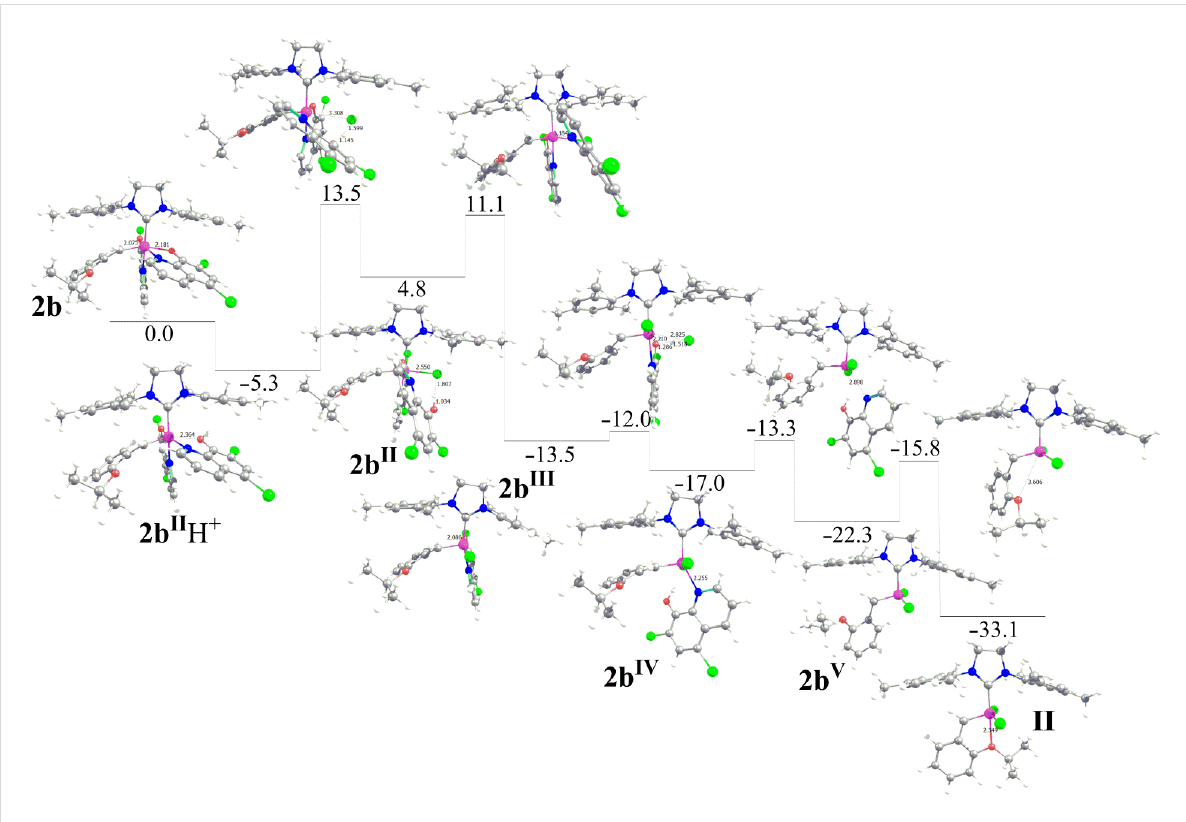
Figure 4: Reaction pathway of the transformation of 2b to HovII (energies in kcal/mol; main distances in Å).